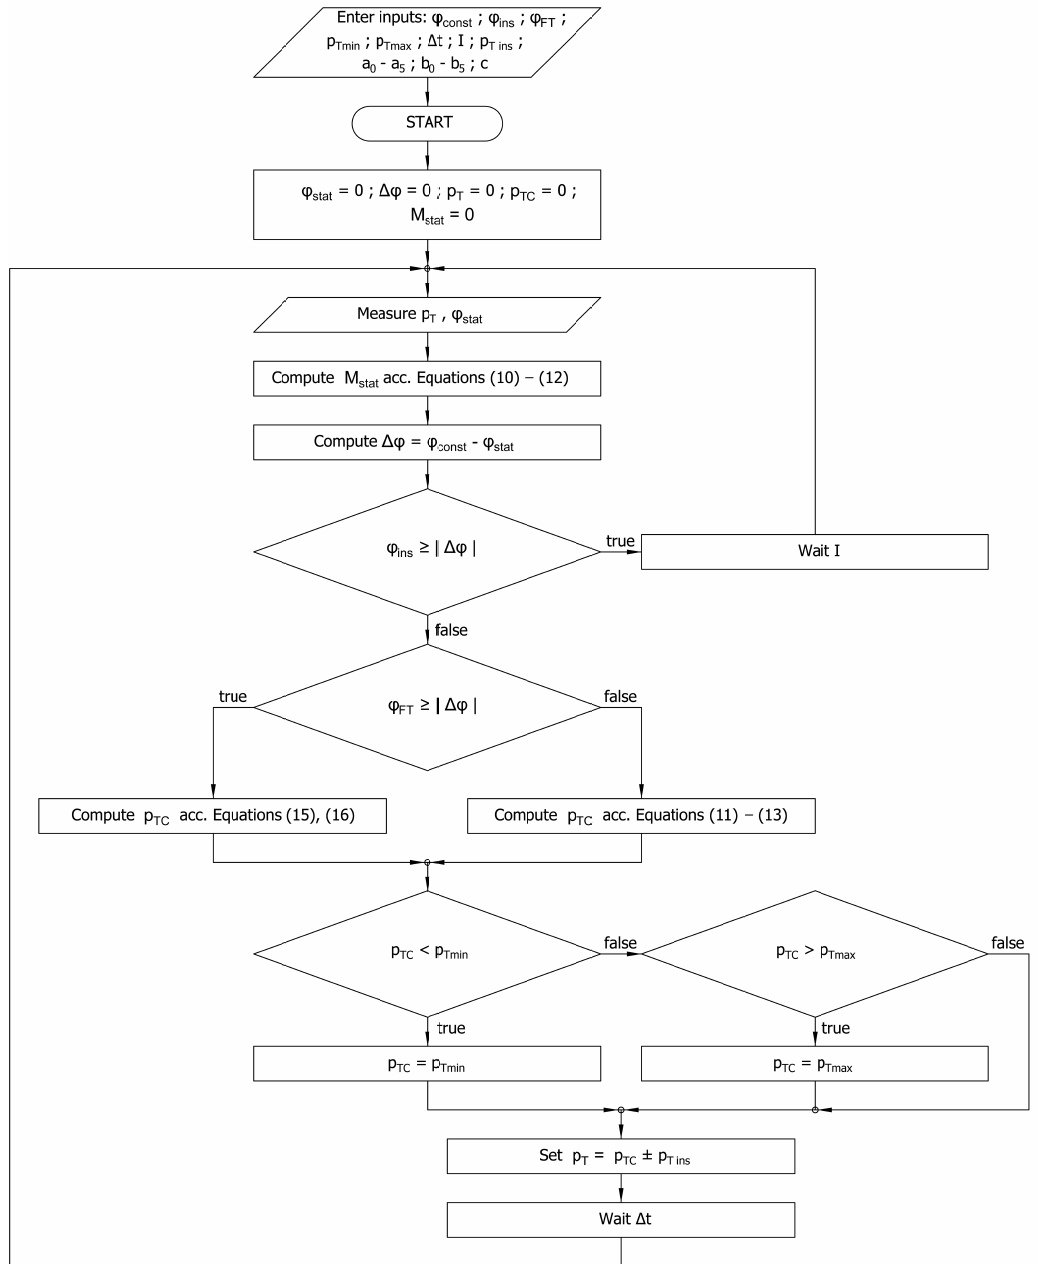
Figure 7. Flowchart of constant twist angle control